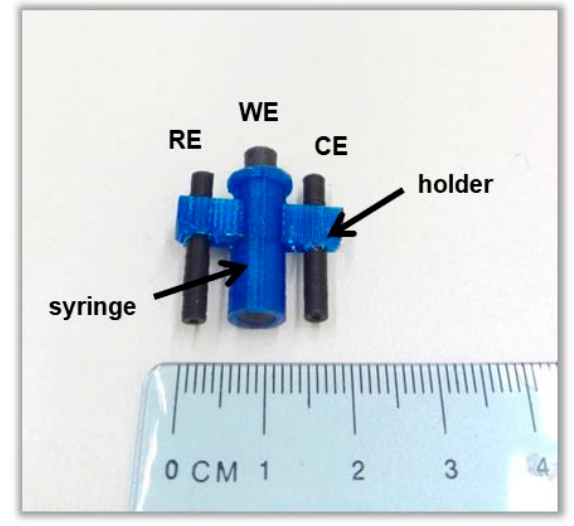
Figure 1. Photograph of the 3D-printed device.